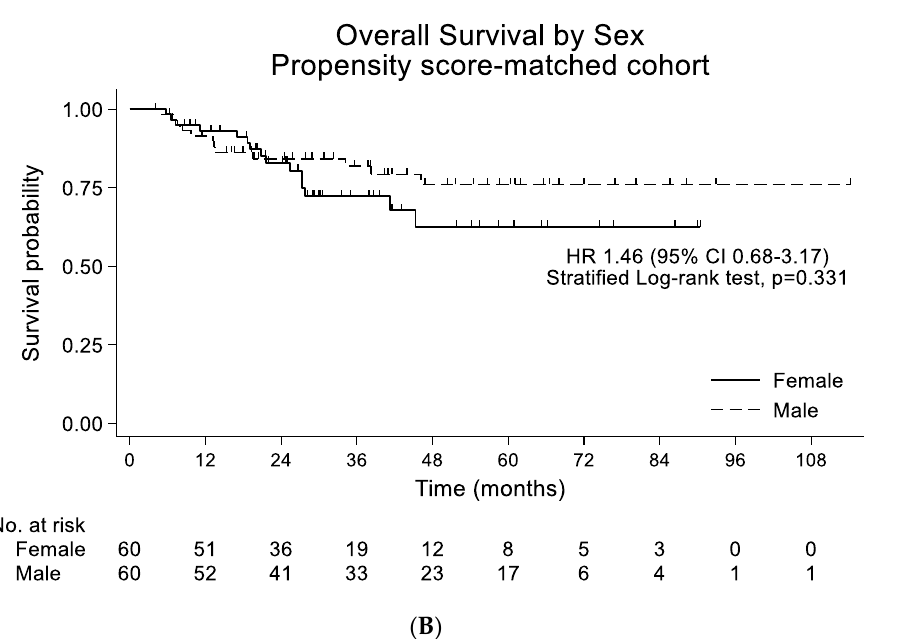
Figure 1. ( A ) Overall survival by sex in entire population (n = 445). ( B ) Overall survival by gender in propensity-score-matched population (n = 120).